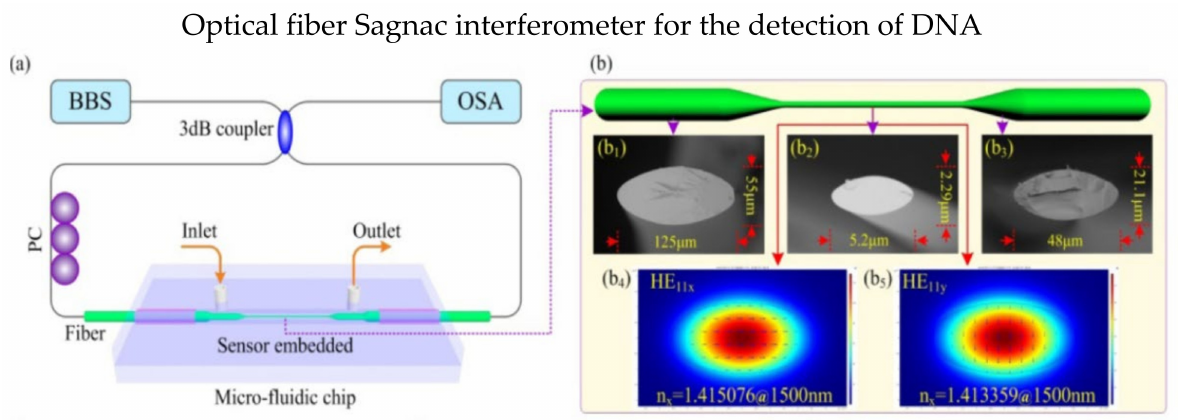
Figure 7. ( a ) Schematic diagram of SI DNA biosensor. ( b ) Profile images of high birefringence elliptical microfiber and the transverse electric field amplitude distributions. ( b1 ) The normal size of elliptical microfiber has a major axis of 125 µ m, ( b2 ) the waist of the microfiber is about 5.2 µ m, ( b3 ) the transition regions have a major axis of 48 µ m. Transverse electric field amplitude distributions of ( b4 ) x − polarized mode and ( b5 ) y − polarized mode. Reprinted with permission from Ref. [84]. Copyright 2017, Optical Society of